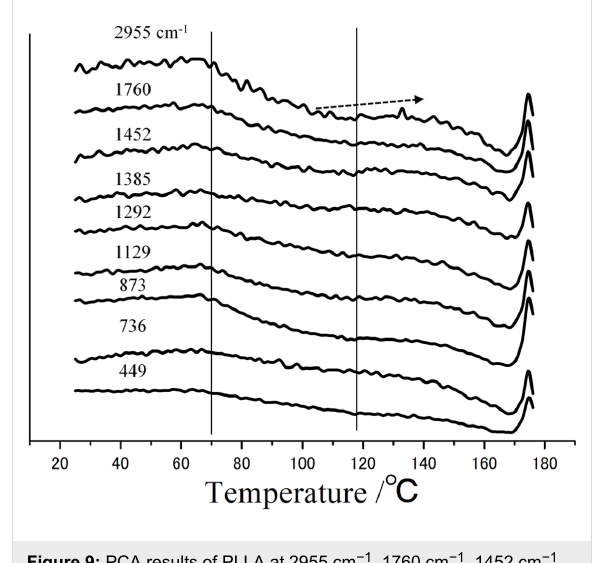
Figure 9: PCA results of PLLA at 2955 cm − 1 , 1760 cm − 1 , 1452 cm − 1 , 1385 cm − 1 , 1292 cm − 1 , 1129 cm − 1 , 873 cm − 1 , 736 cm − 1 and 449 cm − 1 .